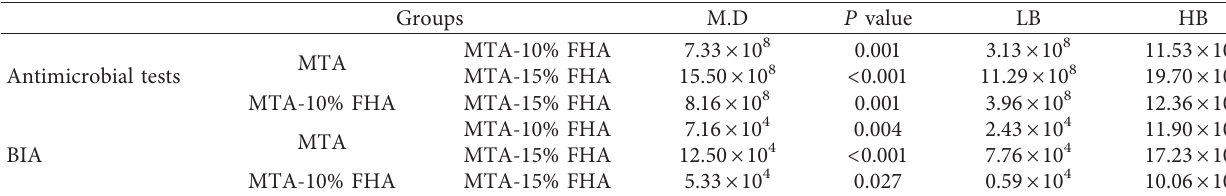
Table 3: Comparison of the study groups based on the DCA and BIA tests.